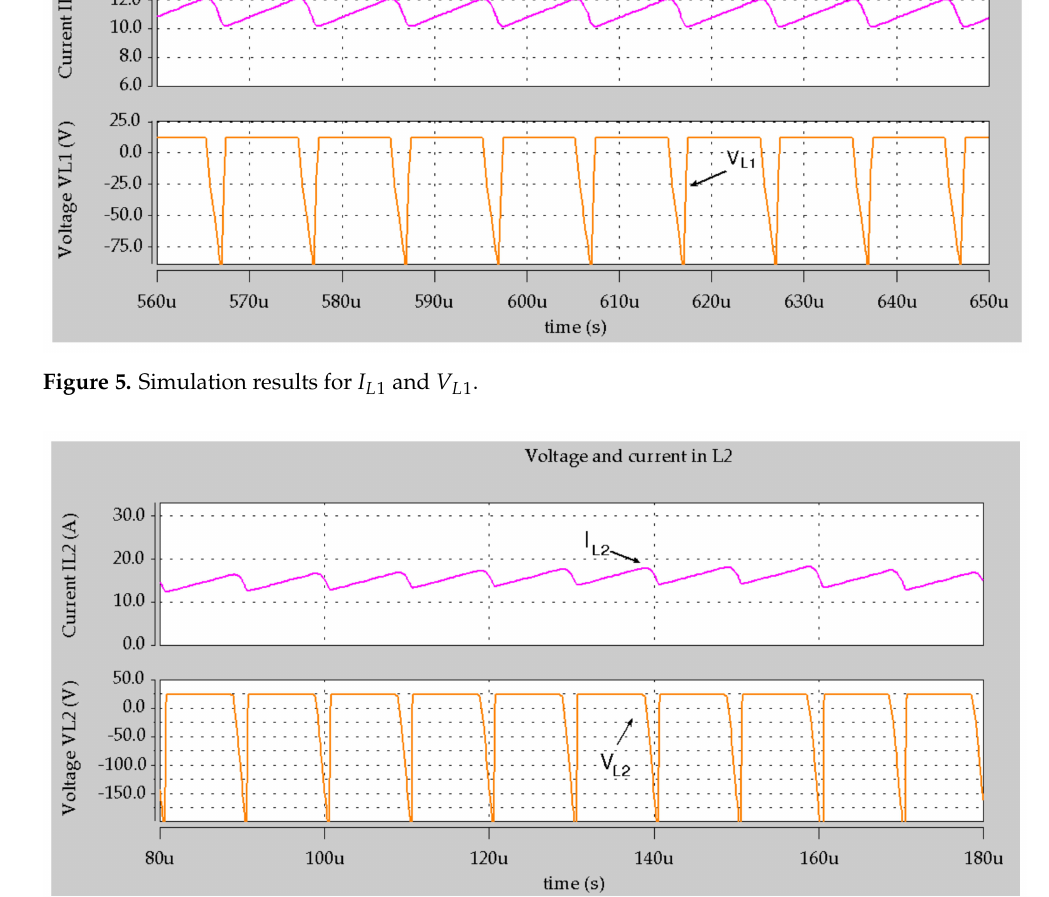
Figure 6. Simulation results for I L 2 and V L 2